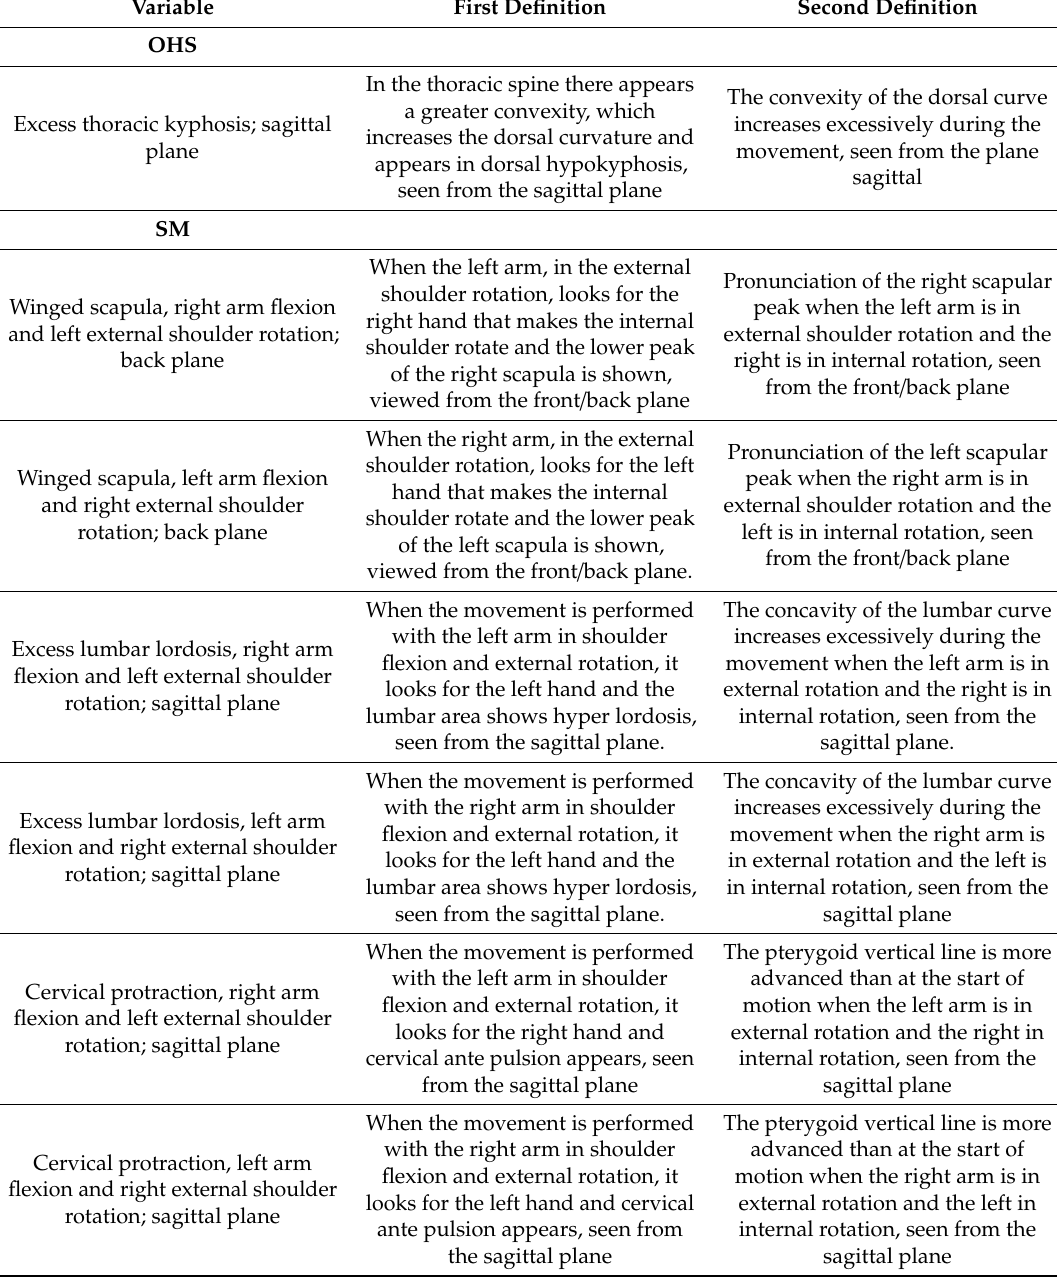
Table 8. Items that have not meet the minimum set value for the degree of definition.